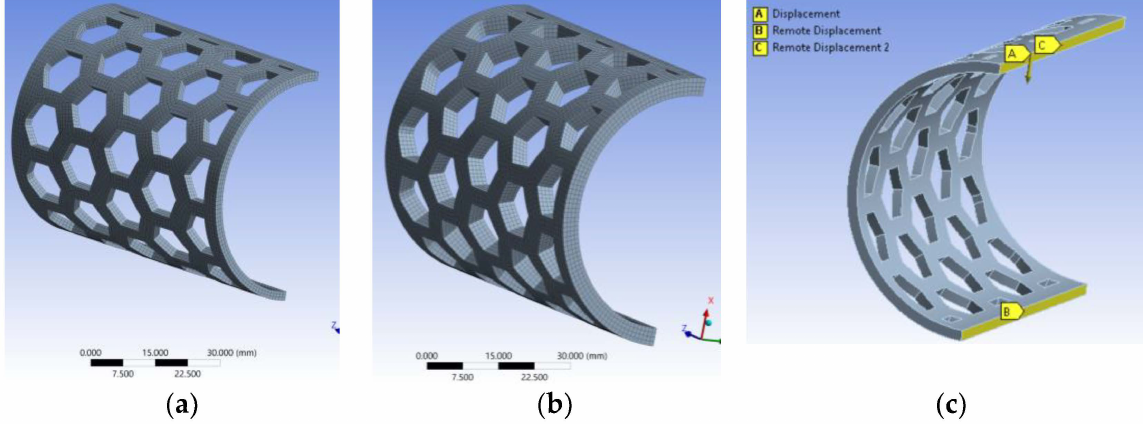
Figure 5. Meshing the models: 2 mm thick model ( a ); 4 mm thick model ( b ); external displacement and constraints ( c